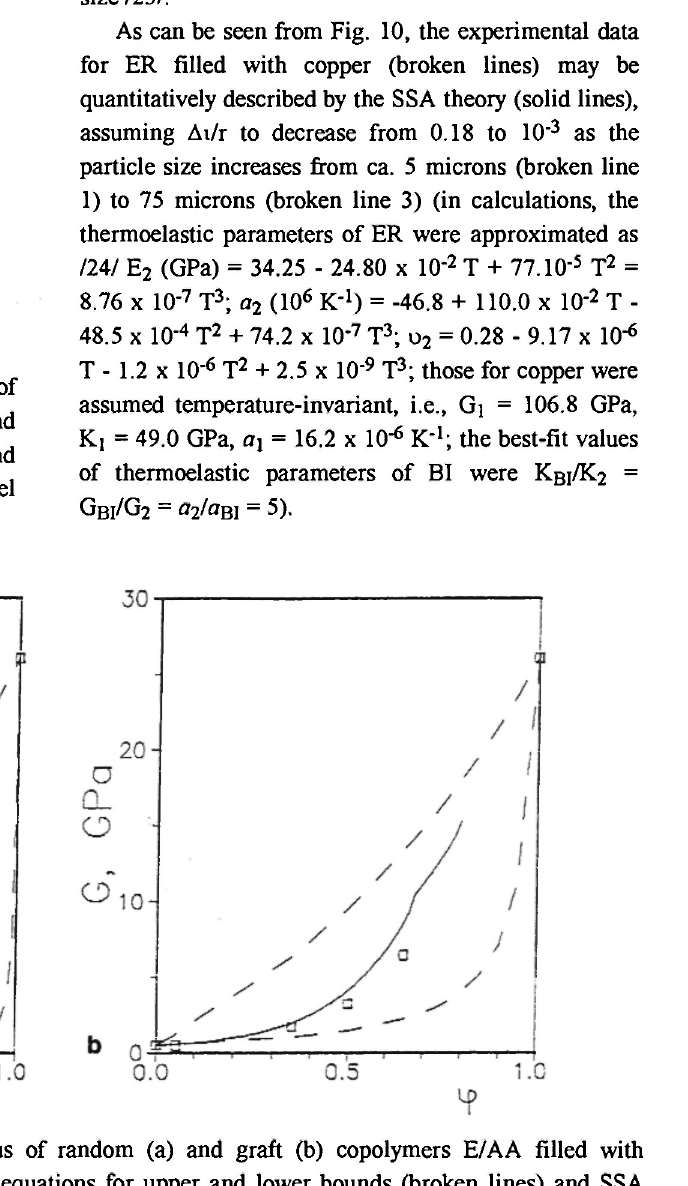
Fig. 9: Composition dependence of shear modulus of random (a) and graft (b) copolymers E/AA filled with aluminium (points) and predictions of HS equations for upper and lower bounds (broken lines) and SSA model (solid